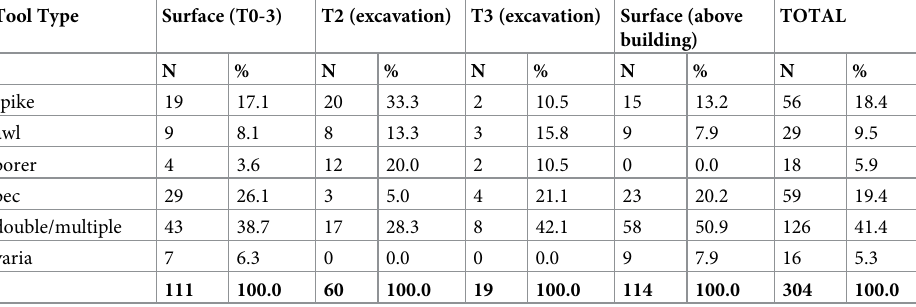
Table 9. ‘Borers and Awls’ tool types–Kaizer Hill